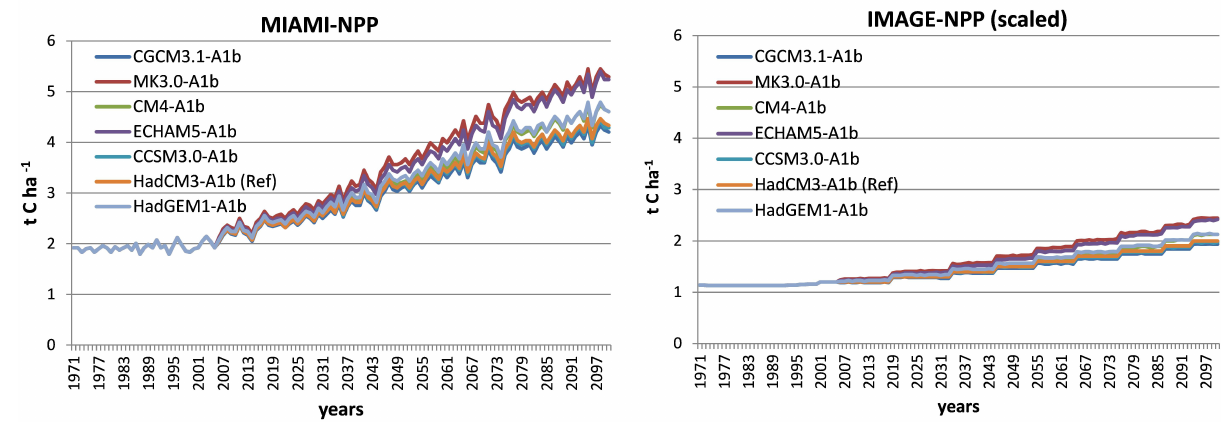
Fig. 3. Example of the NPP-scaling approach for an arbitrary grid cell. The panel on the left depicts NPP values calculated based on mean yearly temperature and precipitation for the seven AOGCMs. The panel on the right shows the correspondingly scaled IMAGE-NPP values with HadCM3 being associated with the IMAGE-A1b-NPP surface.